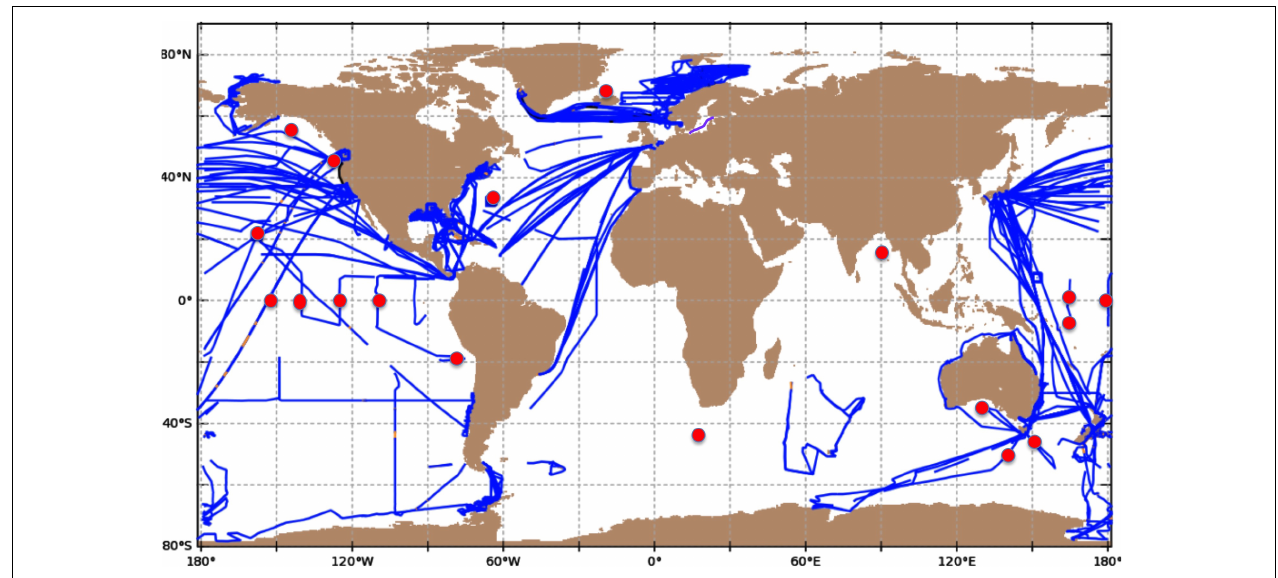
FIGURE 3 | Ship lines and moorings that currently meet SOCONET data quality and are potential contributors to the SOCONET effort. Lines are based on the SOCAT holdings from 2017 to 2018 with pCO 2 data that are believed to be accurate to within 2 µ atm. The mooring sites with systems meeting the data quality standards are indicated by red